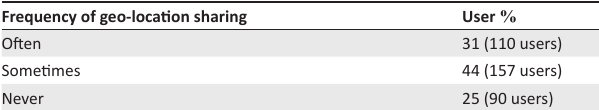
TABLE 1: Sharing of geo-location.